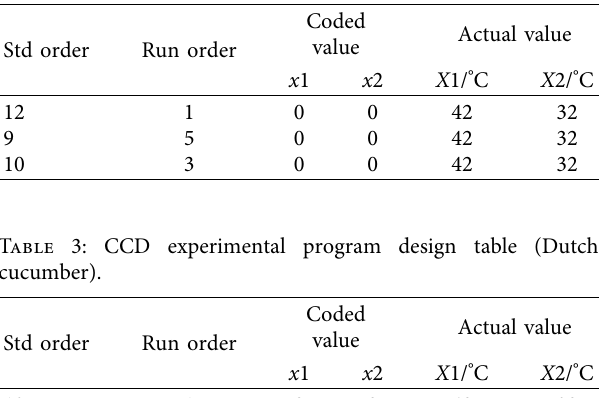
Figure 7: Heat treatment test cucumbers. Table 2: CCD experimental scheme design table (Fire Phoenix).